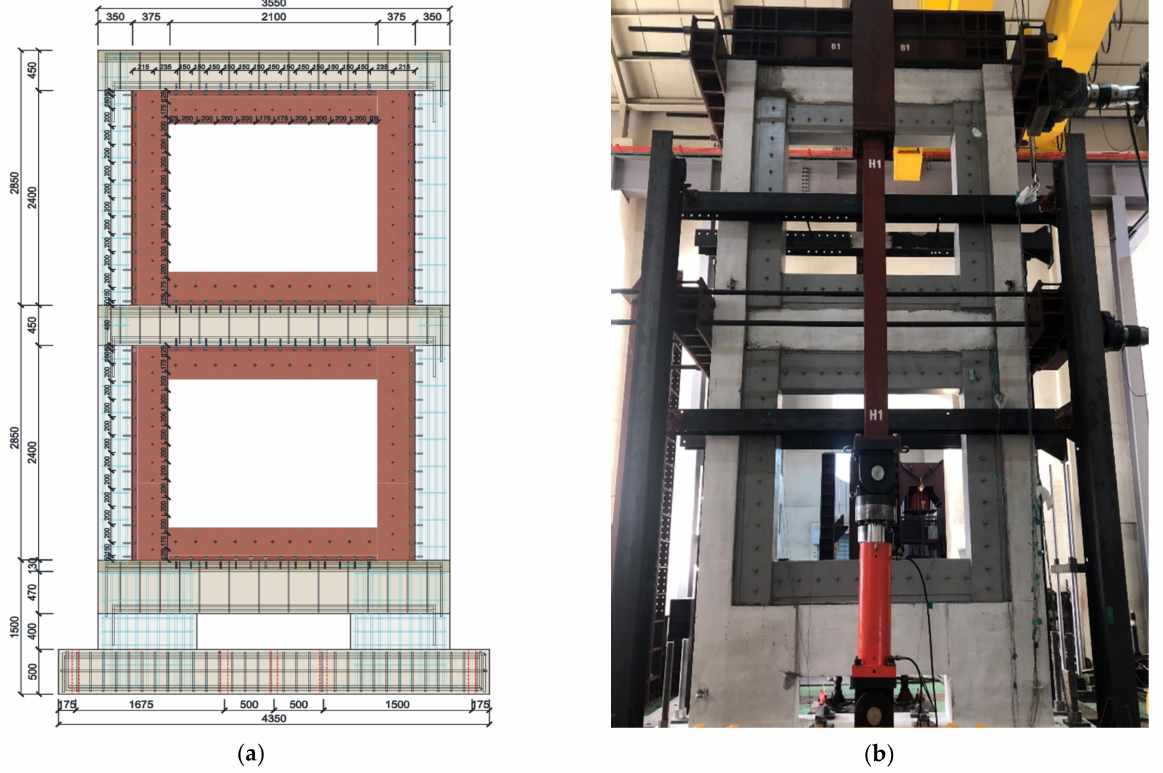
Figure 9. Bar arrangement details and image of test frame retrofitted with CFT-MF system (PD-CFT): ( a ) bar arrangement details and ( b )